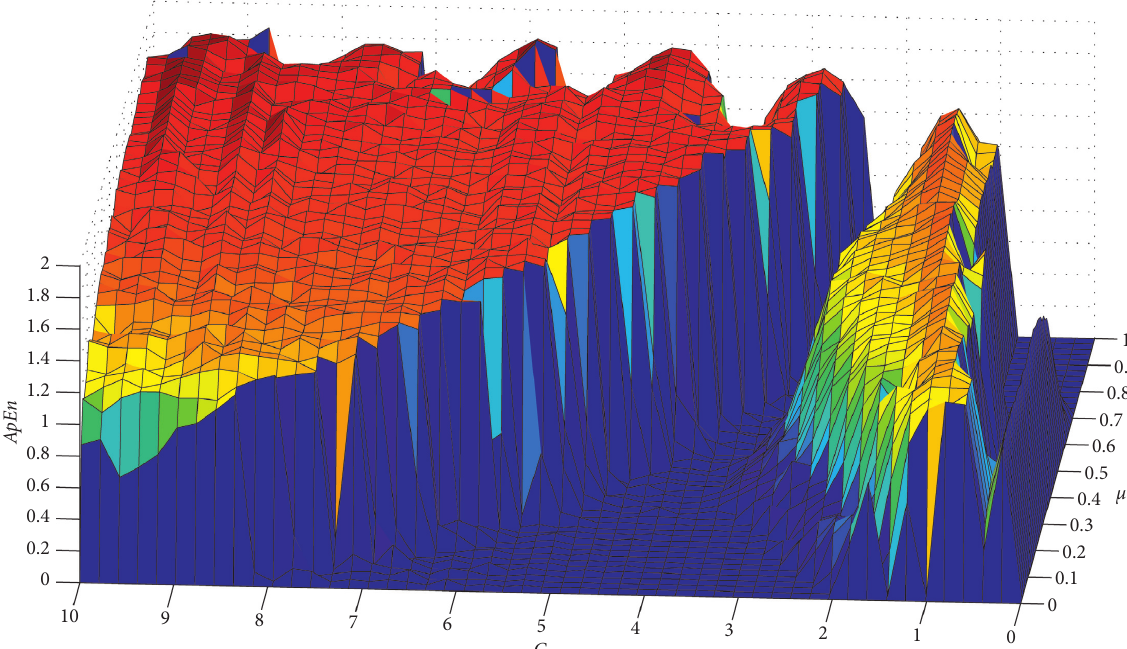
Figure 11: The approximate entropy ApEn of the fractional map (8) in three-dimensional space with the variation of system parameter C and fractional order μ , for A � 0 . 5 and B �